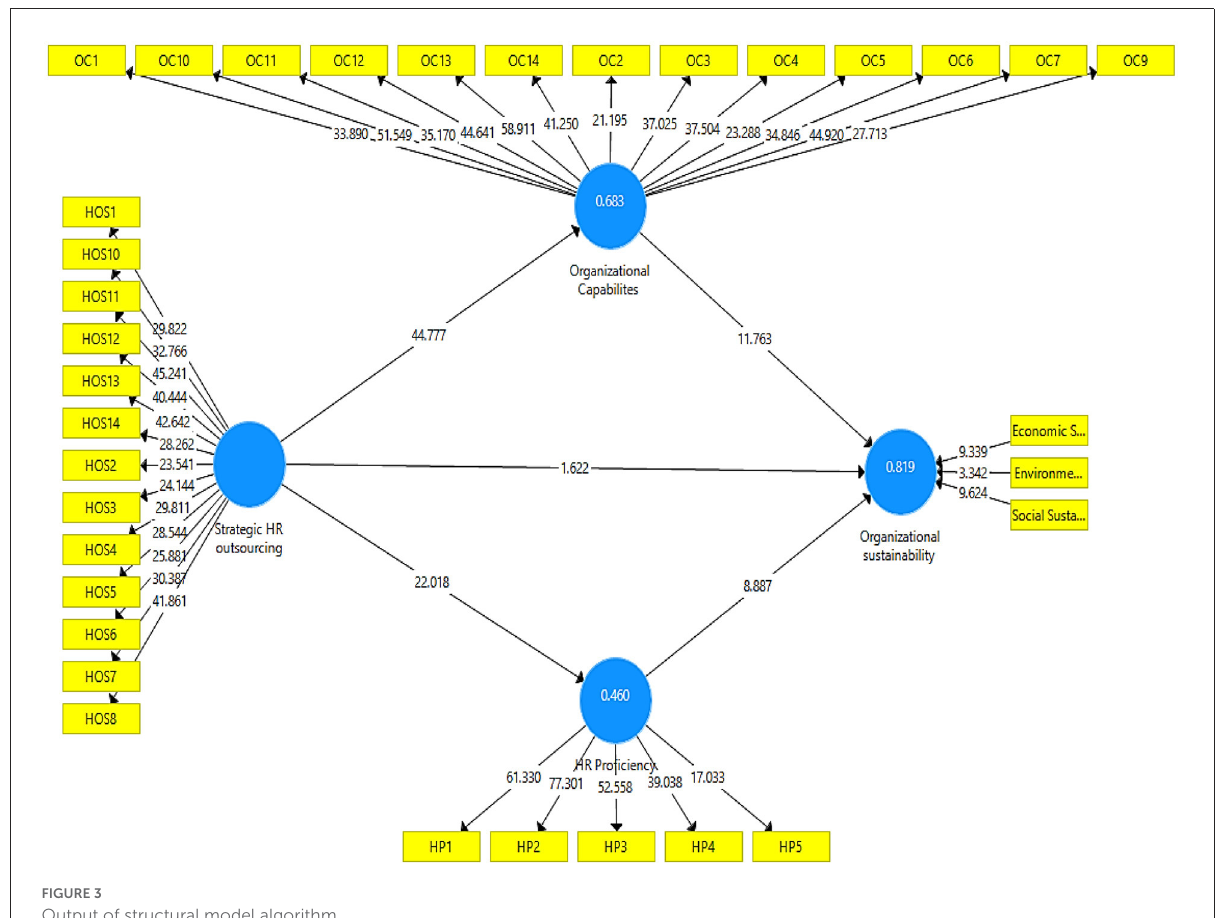
FIGURE3 Output of structural model algorithm.